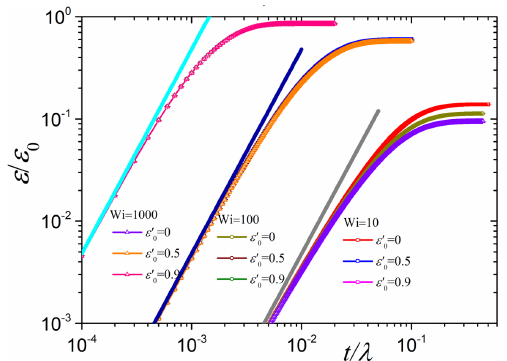
Figure 7. Predictions for the link tension coefficient, ε ( t ) / ε 0 as a function of dimensionless time for N = 100 and various values of the parameter ε (cid:48) and dimensionless elongation rate Wi. The thick 0 ( ˙ (cid:101) t ) 2 according to Equation (19) with b = straight lines give the prediction of 12 25